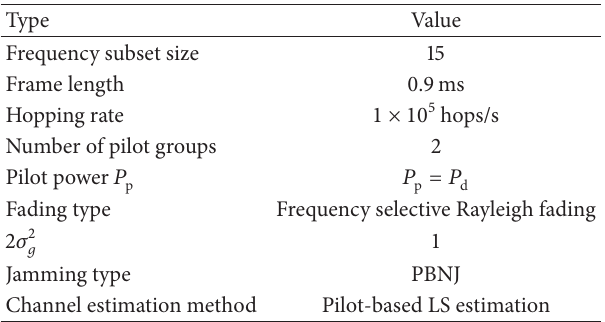
Table 1: Simulation parameters.